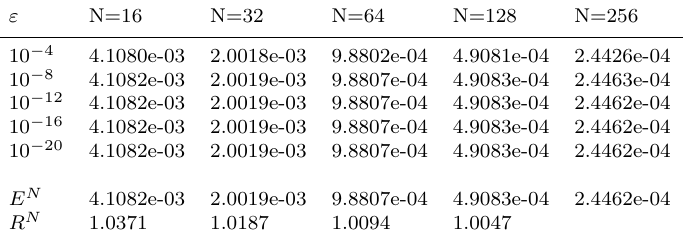
Table 2. Maximum absolute error and rate of convergence for different values of ε and number of mesh point, N with NSFDM for Example